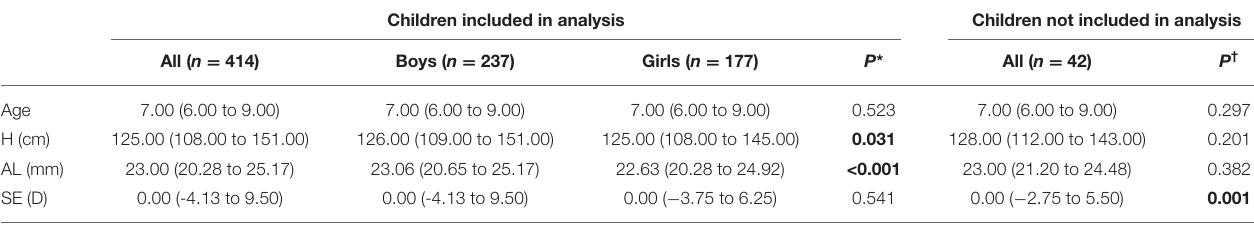
TABLE 1 | Summary of baseline participants’ demographic characteristics. Children included in analysis Children not included in